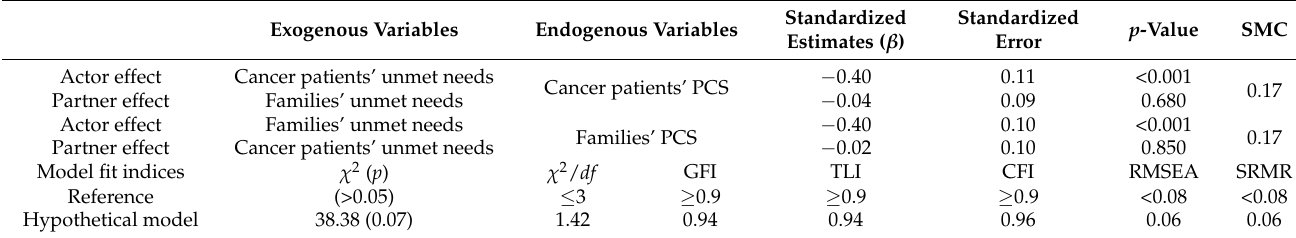
Table 6. Actor–partner effects and the model fit (PCS).